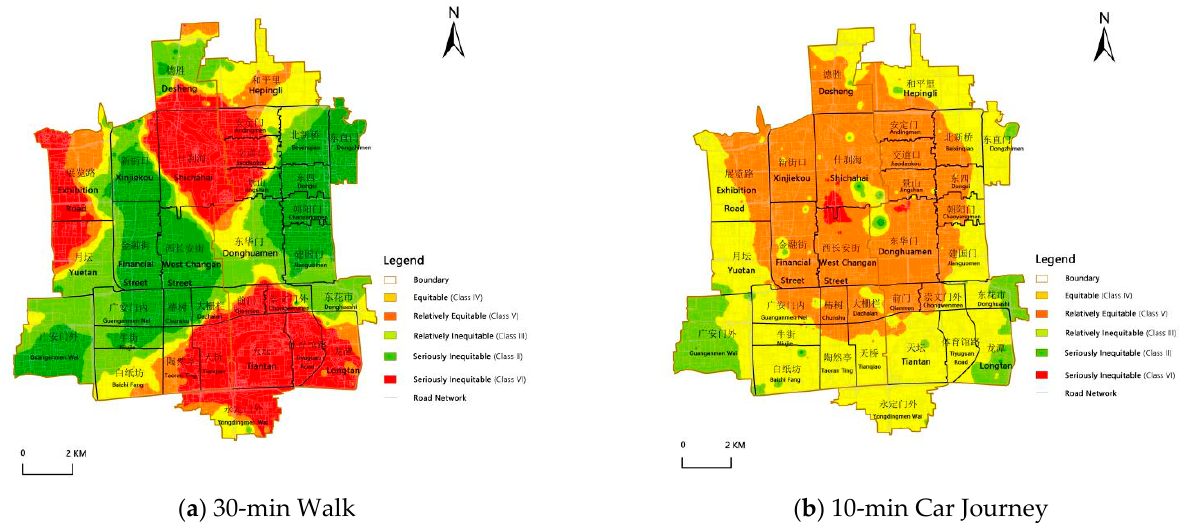
Figure 6. Overall equity value diagram. ( a ) Equity values for the whole core area of Beijing within a 30-min walk; ( b ) equity values for the whole core area of Beijing with a 10-min car journey. Table 6. Supply classification for overall area with walking 30 min and driving 10 min by car.